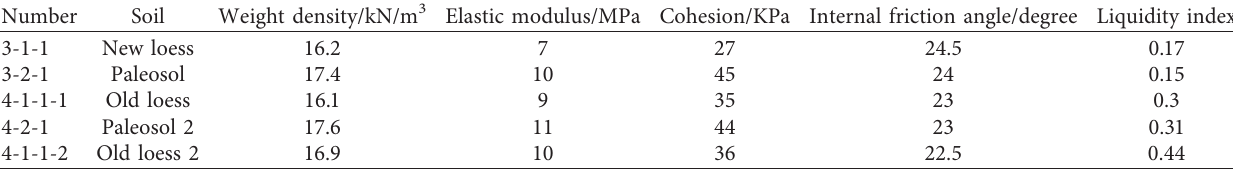
Table 1: Physical and mechanical properties of the soil